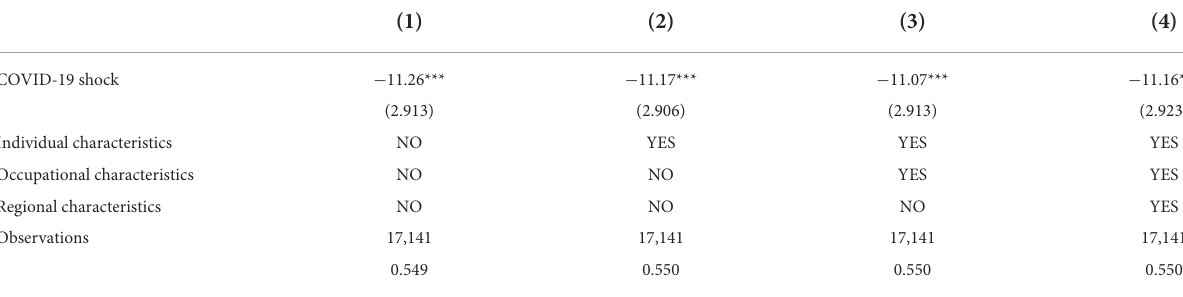
TABLE 3 Effect of COVID-19 on income (whole sample).